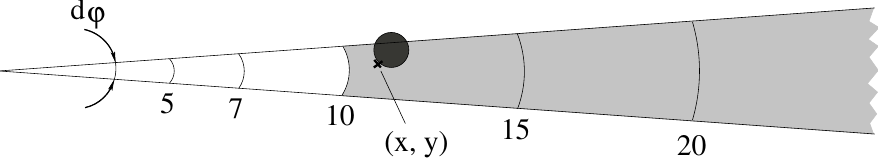
Figure 1. Processing of the point cloud and tree location data for visibility calculations. A TLS echo or tree stem demarcates visibility (white) in the sector with opening angle d ϕ (0.05 ◦ or 0.1 ◦ ) at some particular distance (in m). For clarity, d ϕ is drawn with